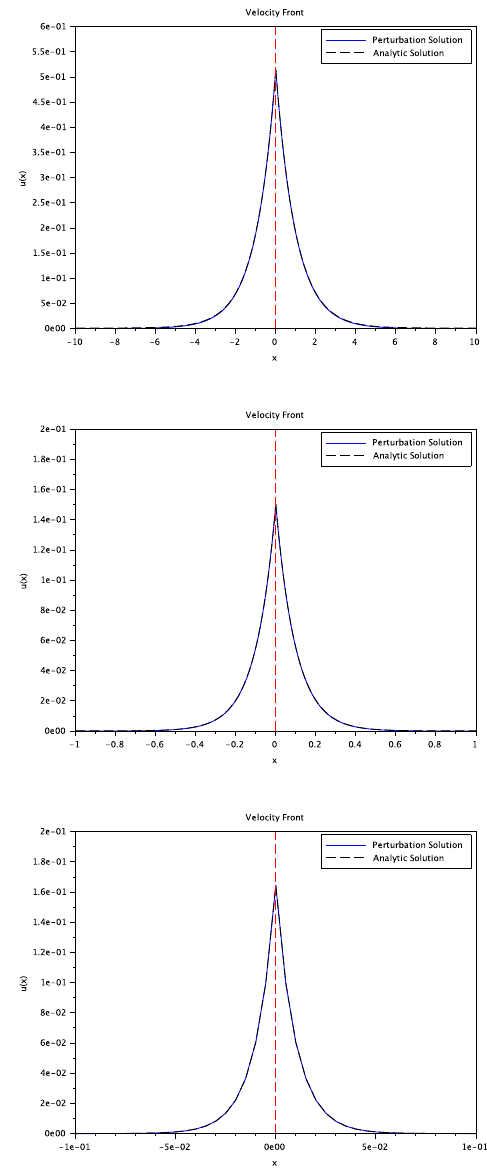
Fig. 3. These are the perturbation solutions given by (23) at time t = 0 graphed with the solution given by 32 with β = 1 and the corresponding values for µ 1 and ξ described in (I) given by the top, β = 10 middle, and β = 100 on bottom. The perturbation solutions are a close approximations for the exact solutions near the region of separation. We can see that the shape of each solution is preserved for each set of parameters, though the scale is